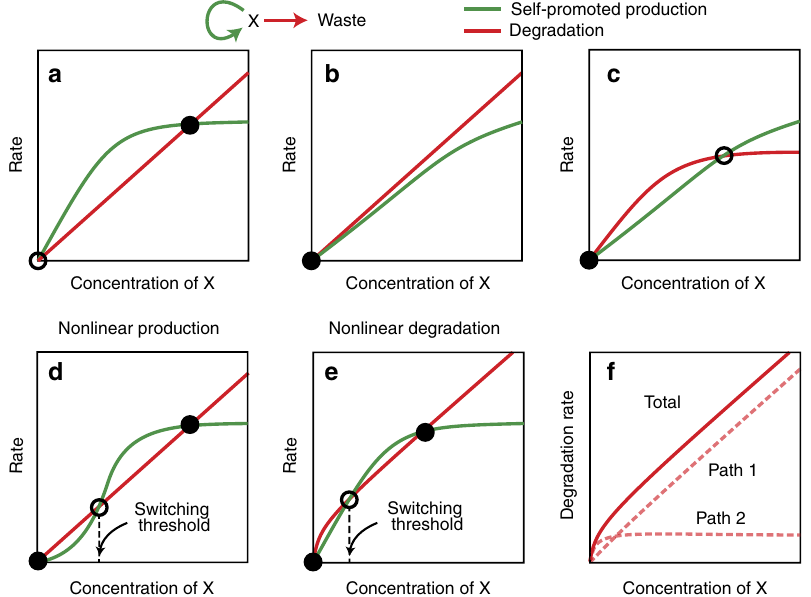
Figure 1 | Stability and threshold in autocatalysis-degradation networks. Species X is produced by an autocatalytic mechanism (green) and subject to degradation (red). ( a – c ) In the case of first-order or linear-saturable production and/or degradation, the system admits at most a single stable steady state (black circle), which can be null or not, depending on relative kinetic parameters (open circles indicate unstable fixed points). ( d ) In the case where production is of a higher order, slower production at low concentrations can stabilize the 0 state: the system is now bistable, with a threshold delineating the two basins of attraction. ( e ) The same holds with an ‘increase’ of the degradation rate at low concentrations. ( f ) The degradation curve required in case e can be constructed by combining two first-order/saturable degradation paths, one being faster and more saturable than the